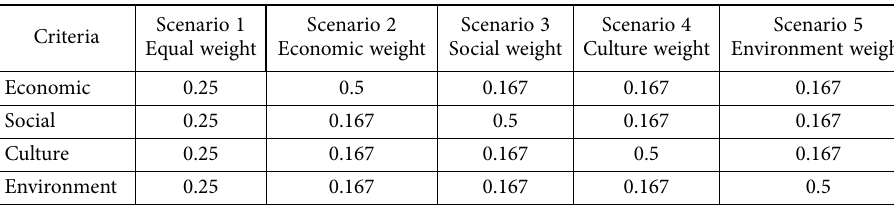
Table 7. Criteria weights under different